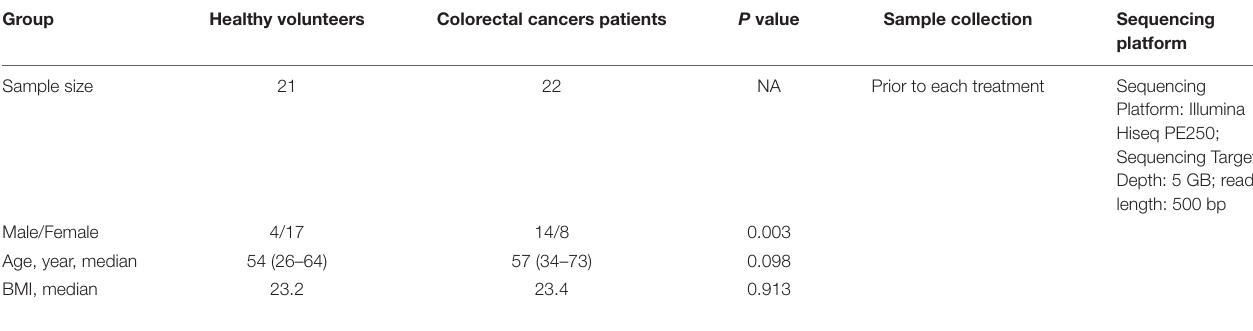
TABLE 1 | Summary information of individuals in this study (Fecal sample’s demographic, clinical, and technical details). Group Healthy volunteers Colorectal cancers patients P